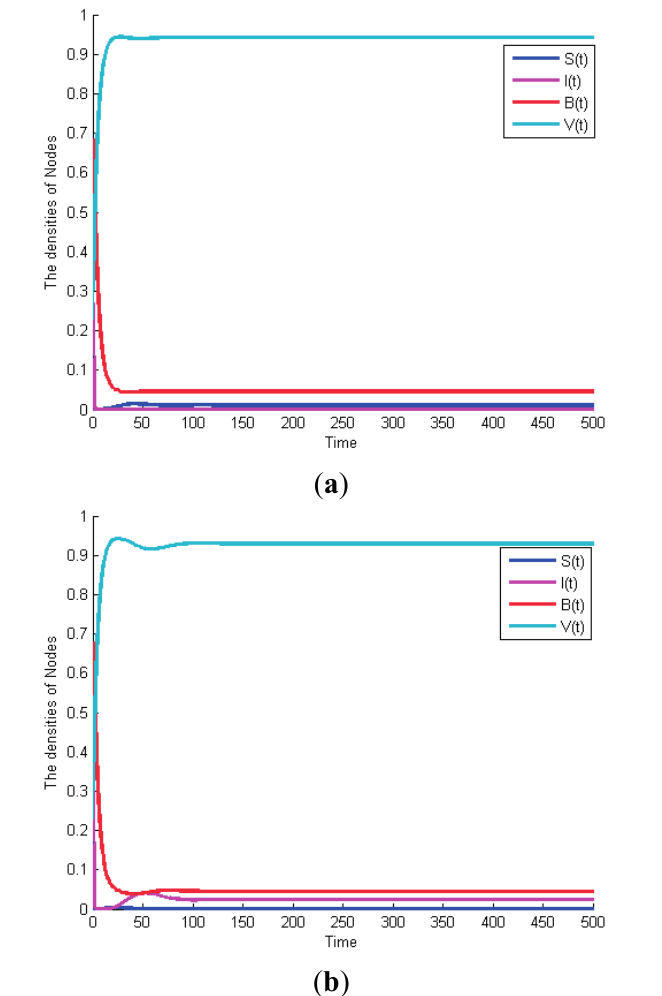
Figure 5. ( a ) Globally asymptotically stable of worm-free equilibrium of System (2) when